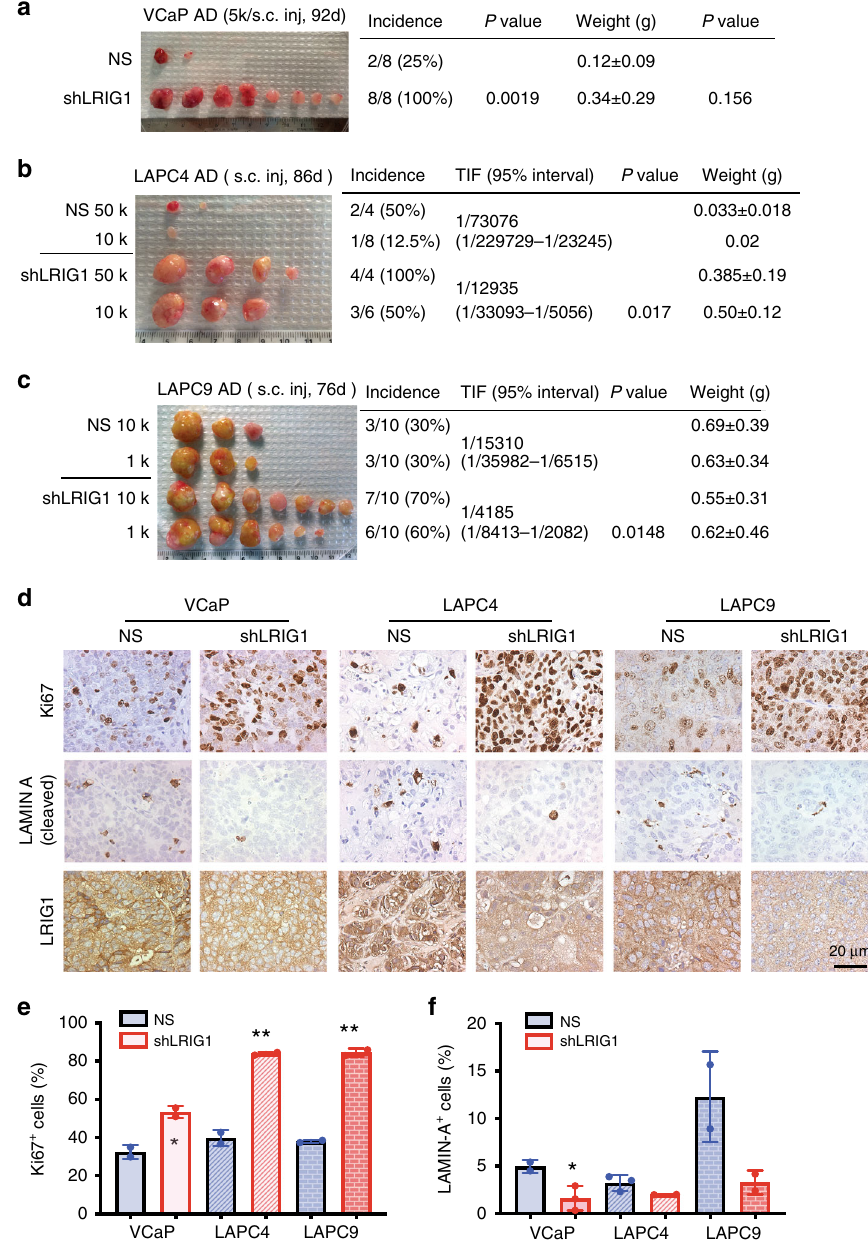
Fig. 3 Knocking down endogenous LRIG1 promotes tumor regeneration in AR + PCa xenografts. a Knocking down endogenous LRIG1 in AR + VCaP cells promotes tumor regeneration and growth. VCaP cells puri fi ed from maintenance tumors were infected with non-silencing (NS) or shLRIG1 lentivectors (MOI 10; 12 h) and 5000 (5k) cells were subcutaneously (s.c) injected in male NSG mice. Tumors were harvested 92 days after implantations. Shown on the right are tumor incidence and weight and corresponding P values ( χ 2 test for incidence and Student ’ s t -test for weight; note that the P value for weight comparison was not statistically signi fi cant due to low tumor incidence in the NS group). b , c Limiting dilution tumor regeneration assays in LAPC4 ( b ) and LAPC9 ( c ) AD cells upon LRIG1 knockdown. Cells freshly puri fi ed from maintenance AD xenografts were infected as in A and implanted at two cell doses in male NOD/SCID mice. Tumors were harvested at the indicated time points. Tumor-initiating frequency (TIF) was calculated and compared ( χ 2 test). d Representative IHC images of LRIG1 (Sigma mAb), Ki67, and cleaved LAMIN A staining (see Fig. 2c for dilutions of these three antibodies) in endpoint VCaP, LAPC4, and LAPC9 xenograft tumors. Tumors derived from LRIG1 KD cells contained more proliferating (Ki67 + ) cells than control tumors. Original magni fi cations were ×400 and a scale bar was indicated on one panel. e , f Quanti fi cation of Ki67 + ( e ) and cleaved LAMIN A + ( f ) cells in endpoint tumors indicated. Bars represent mean ± SEM by counting 1000 – 1500 cells from 2 to 3 individual tumors in each model. * P < 0.05; *** P < 0.001 (two-tailed unpaired Student ’ s t -test). *Source data for Fig. 3a, b, c, e, f are provided as a Source Data fi